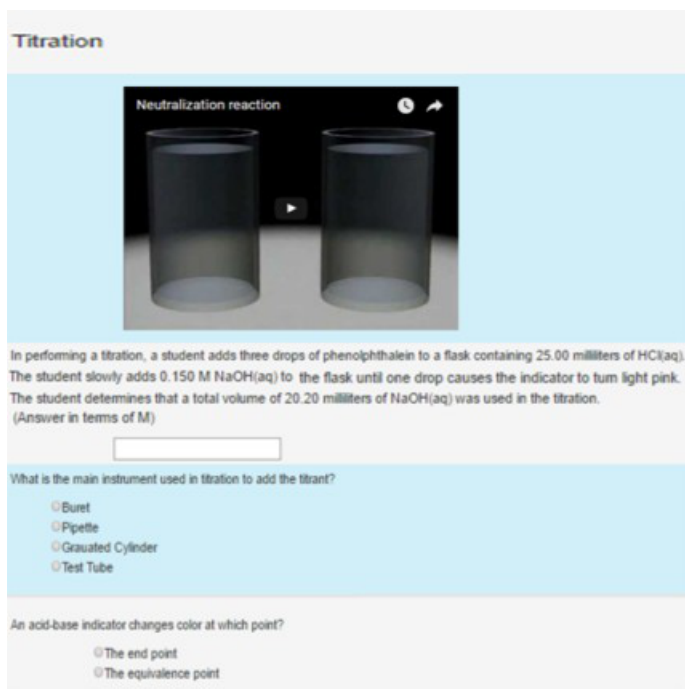
Figure 4. The embedded YouTube video along with the pre-lab